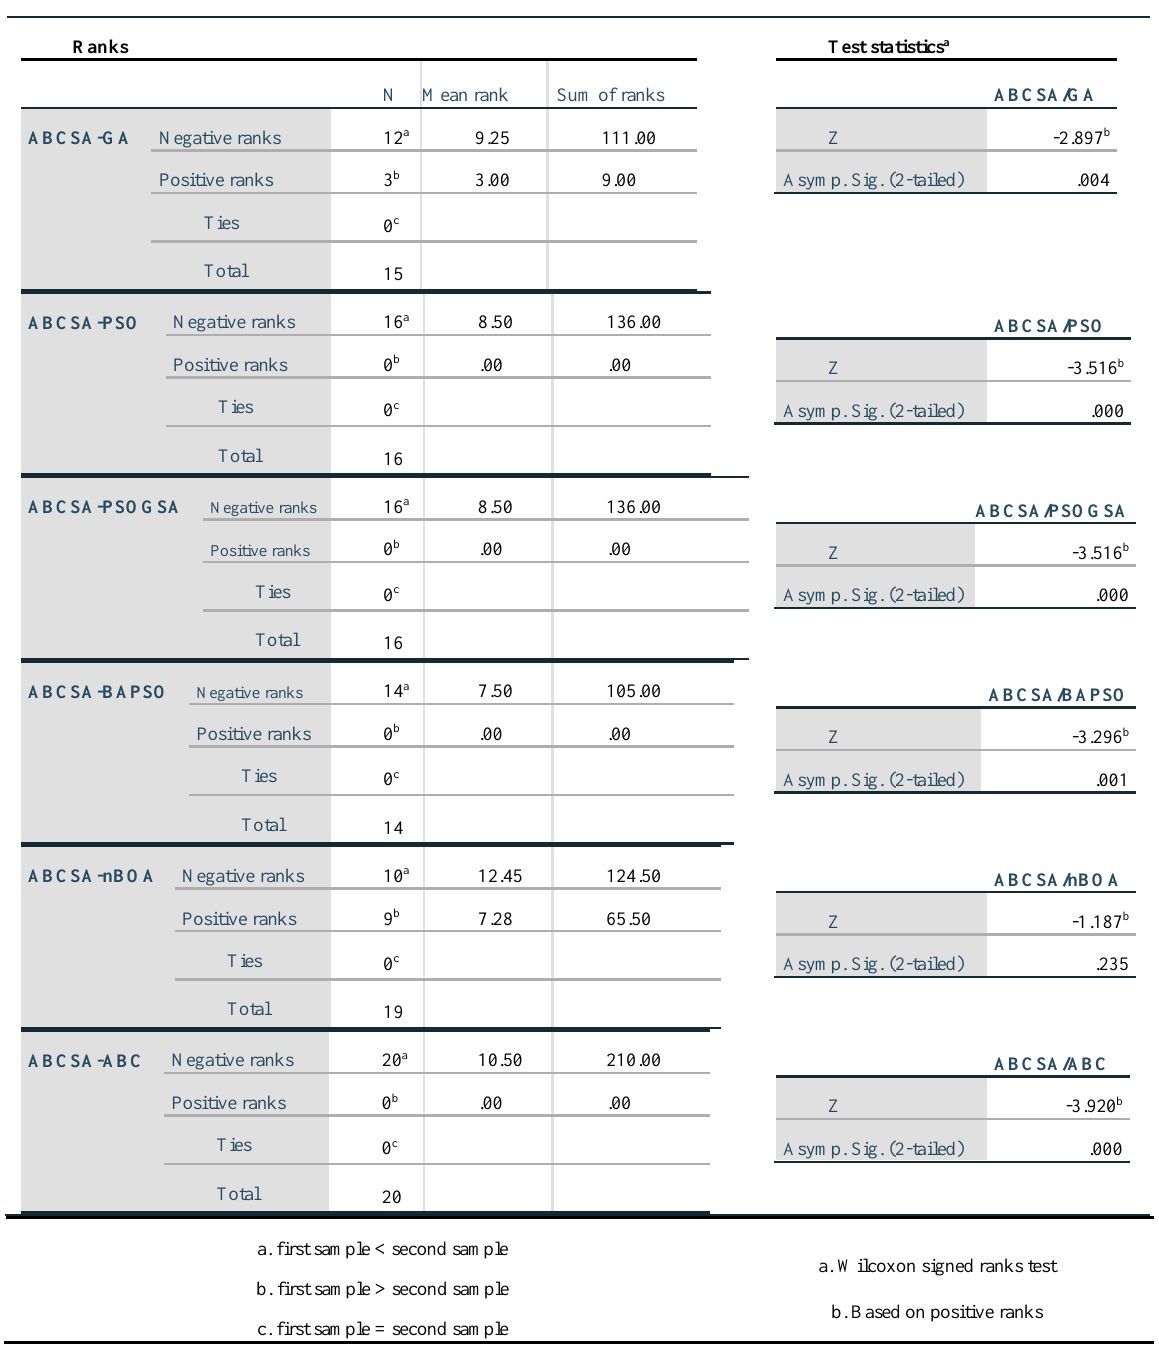
Table 8. Results of the Wilcoxon signed-rank test on ABC-SA with other